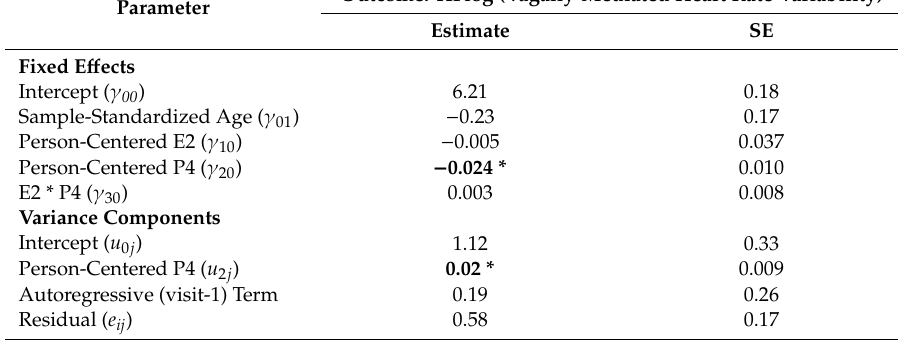
Table 6. Multilevel Regression Models Predicting Log High Frequency Heart Rate Variability (HFlog) from Estradiol (E2) and Progesterone (P4) in Study Two ( N = 150